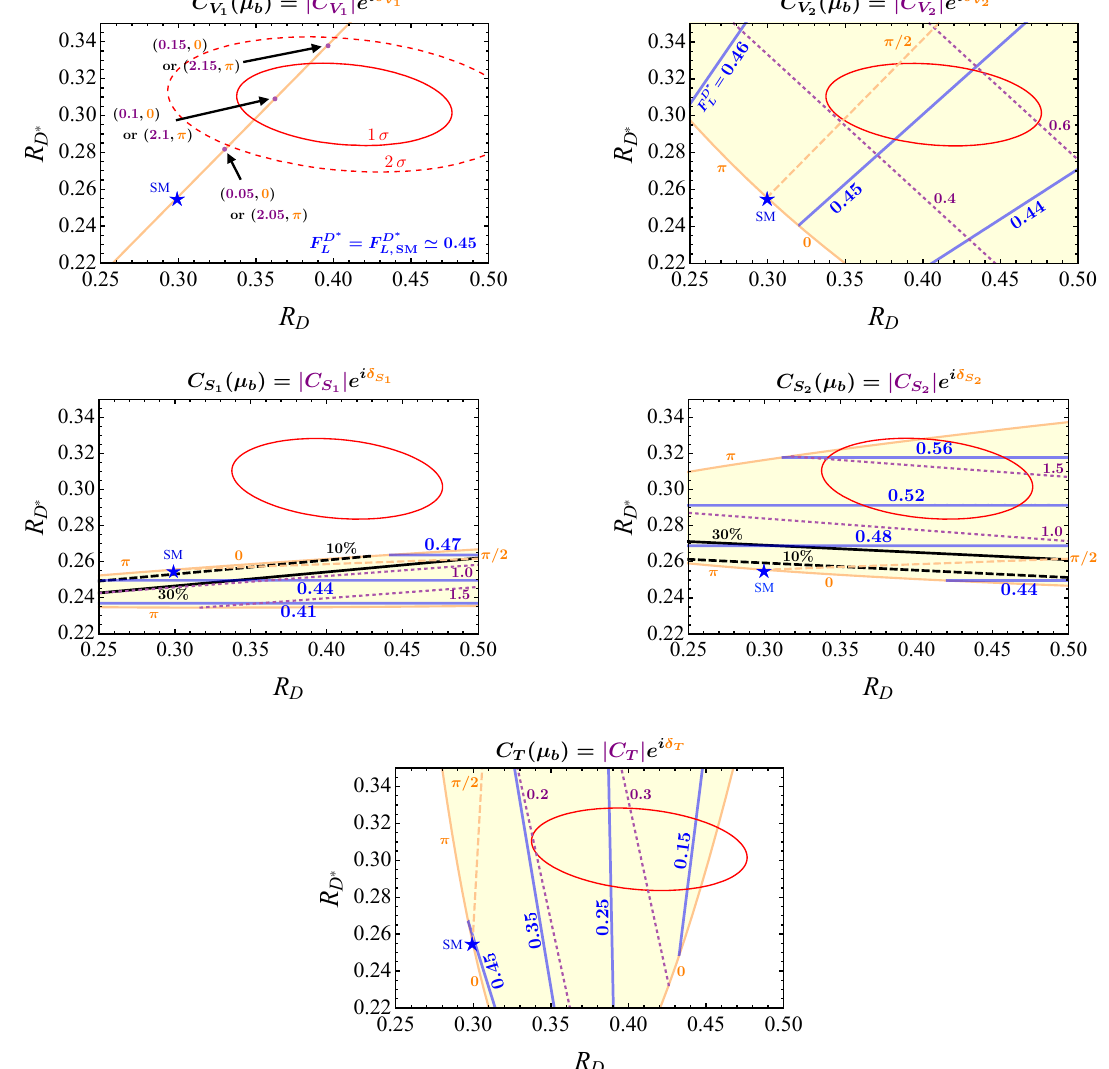
Figure 1. The contour for F D (cid:3) is shown with the blue line on the R D { R D (cid:3) plane in the single L NP operator scenario. The purple and orange lines represent the absolute value and the phase of C X ( (cid:22) b ), respectively. The constraint from the B + lifetime is drawn by the solid (dashed) black c line for B ( B + ! (cid:28) + (cid:23) ) < 0 : 3 (0.1). The world average of the data at 1 (cid:27) (2 (cid:27) ) is shown by the red c (dashed) ellipse. The SM point is represented by the blue star.